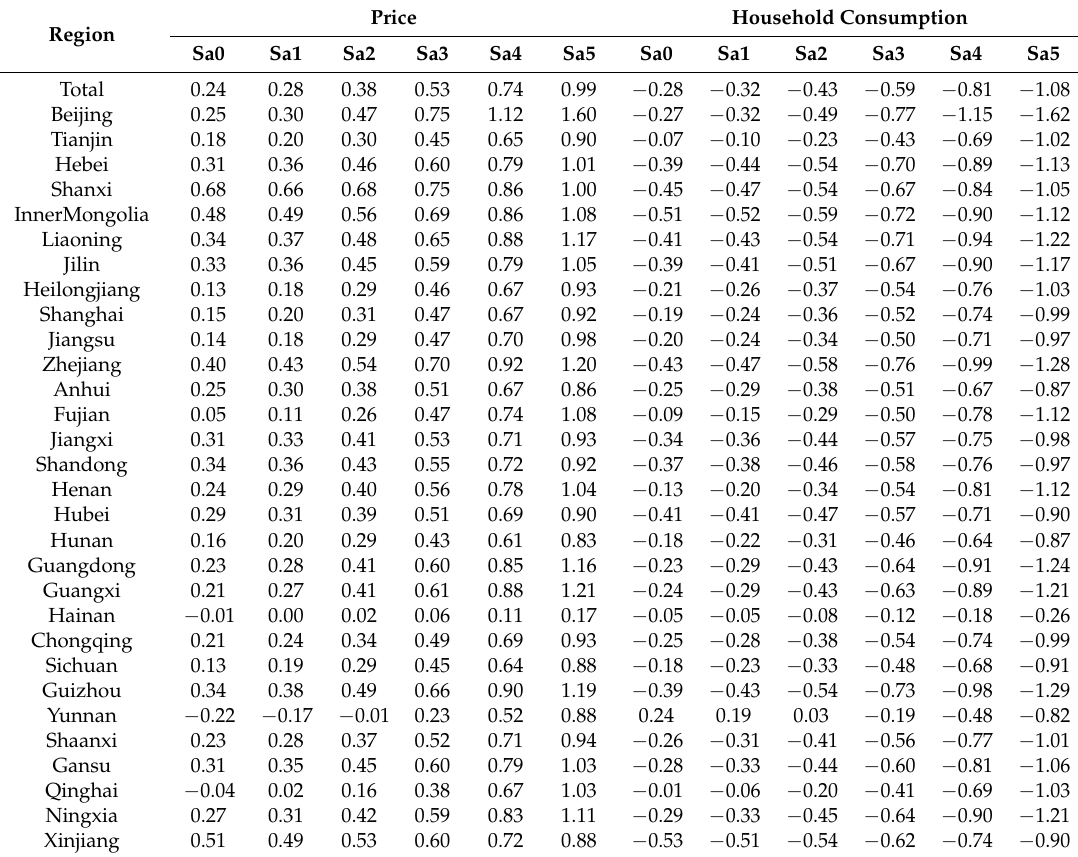
Table 8. Changes in electricity prices and household consumption on electricity in all regions (%).